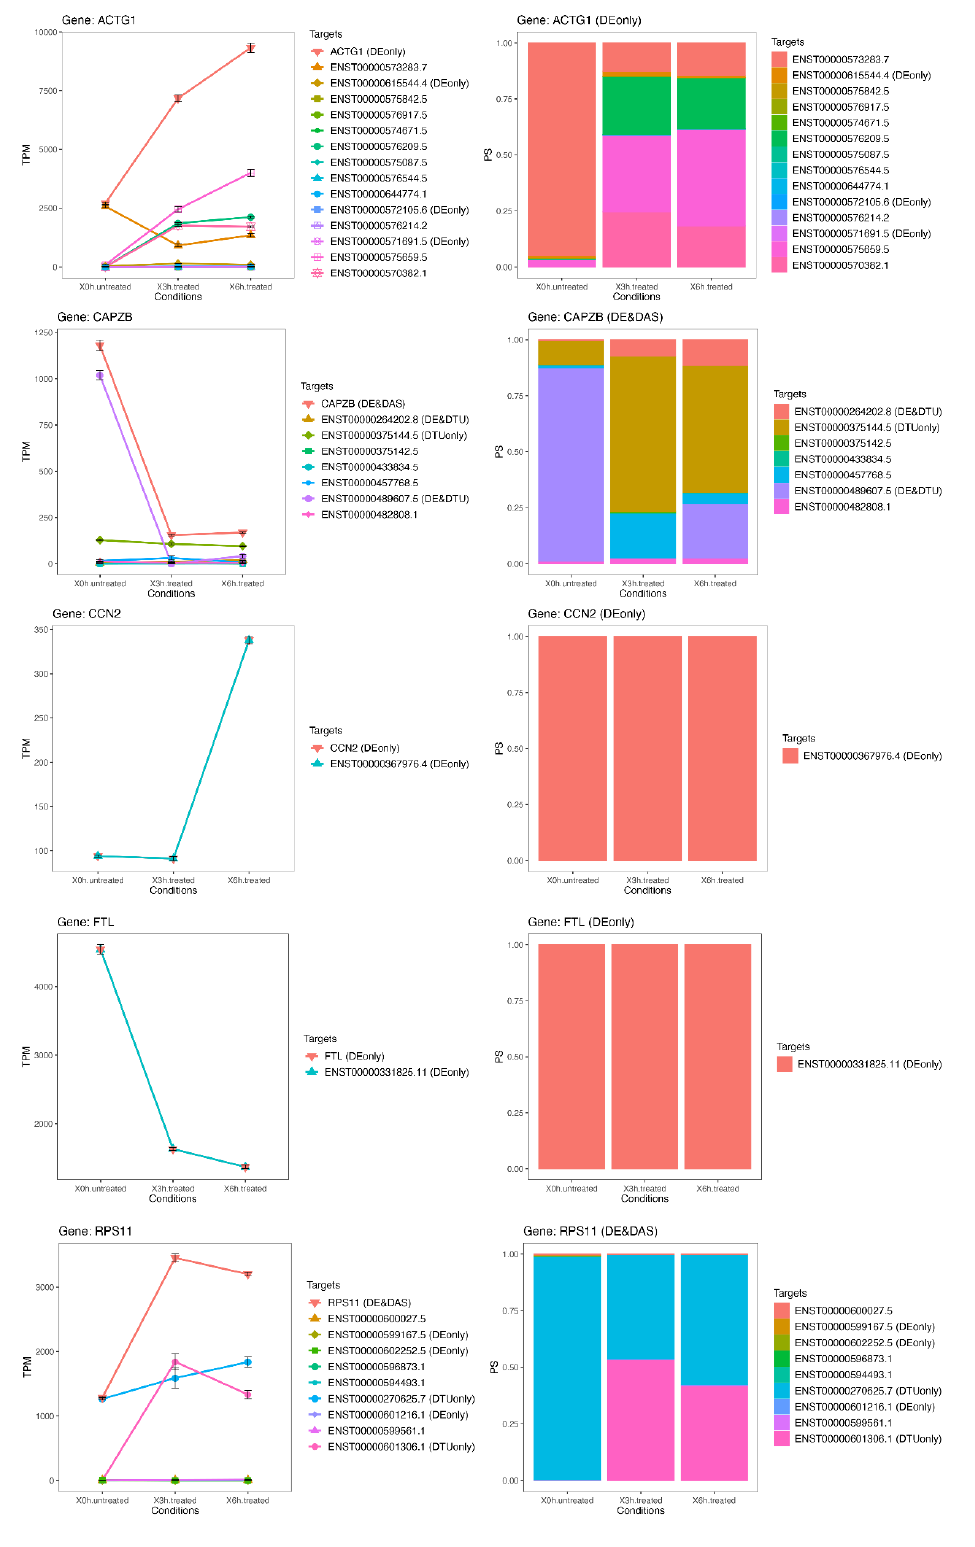
Figure 7. Expression profiles of most important DE genes / transcripts; first cluster associated with newly discovered pathways linked to oxidative stress. Detailed gene / transcript expression profiles across the time course of the first cluster of most important DE genes (ACTG1, CAPZB, CCN2, FTL and RPS11) linked to newly identified candidate pathways linked to oxidative